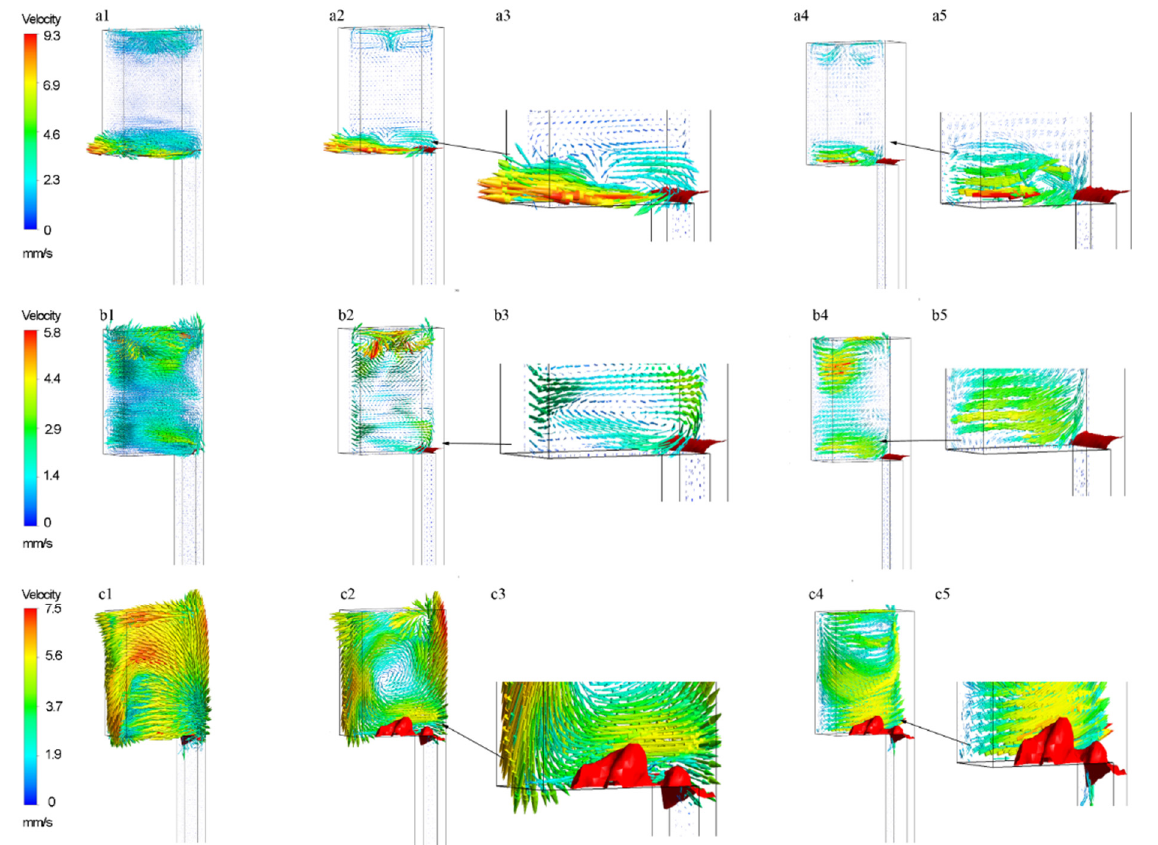
Figure 5. The velocity vectors and the corresponding solidification interface morphology: ( a1 – c1 ) show 3D velocity vectors with I = 10 A, f = 50 Hz; I = 25 A, f = 50 Hz; I = 50 A, f = 50 Hz, respectively; ( a2 – c2 ) show 2D velocity vectors in the mid-vertical plane of ( a1 – c1 ); ( a3 – c3 ) show 2D velocity vectors at front of solidification in ( a2 – c2 ) ; ( a4 – c4 ) show 2D velocity vectors in the surface of ( a1 – c1 ); ( a5 – c5 ) show 2D velocity vectors at front of solidification of ( a4 – c4 ).